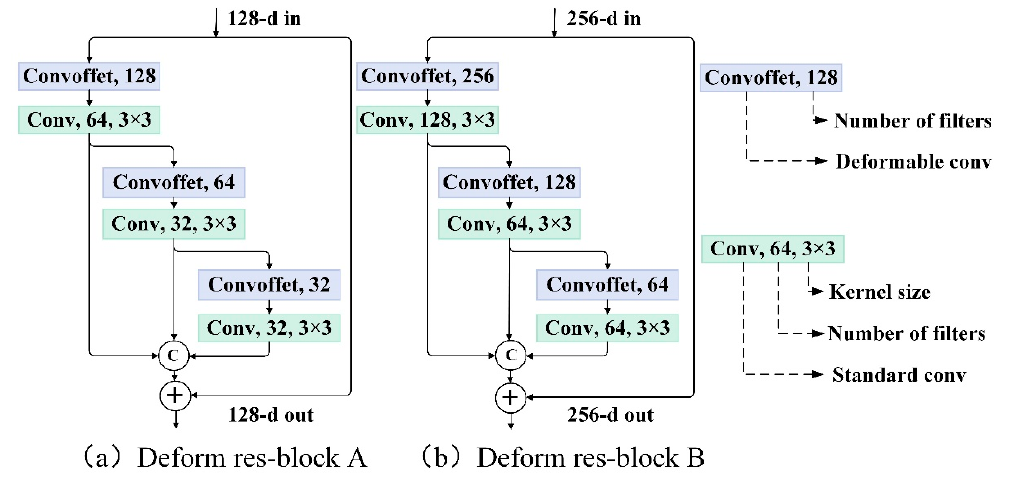
Figure 7. Structure of the deformable multi-scale residual blocks.